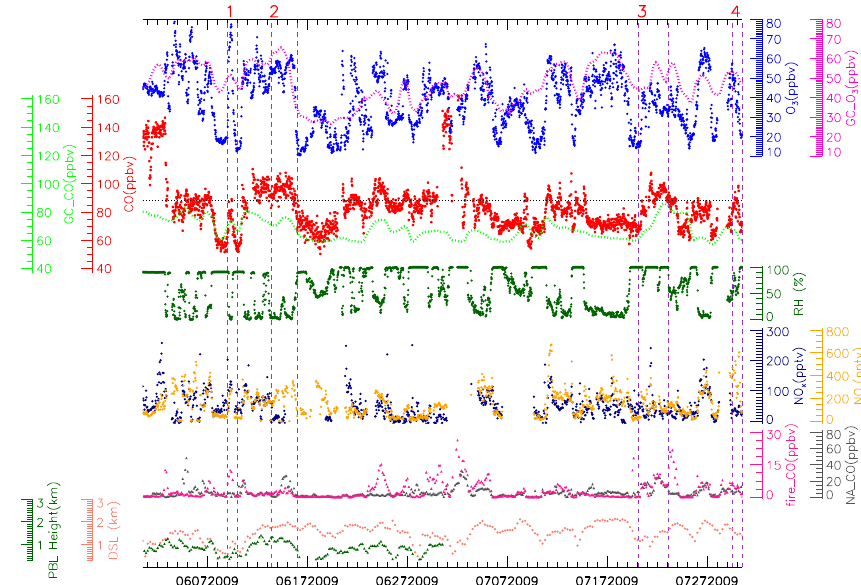
Fig. 1. Time series of 30min average of measurements and meteorological conditions, 6h average contributions from North American anthropogenic emission (NA_CO) and biomass burning emissions (FIRE_CO) calculated by FLEXPART, and 4h average GEOS-Chem CO (GC_CO) and O 3 (GC_O 3 ) at Pico Mountain Observatory station during summer 2009. Data points are colored with corresponding y axes. Vertical dashed lines show time windows of each event, which are labeled with red numbers close by at the top.